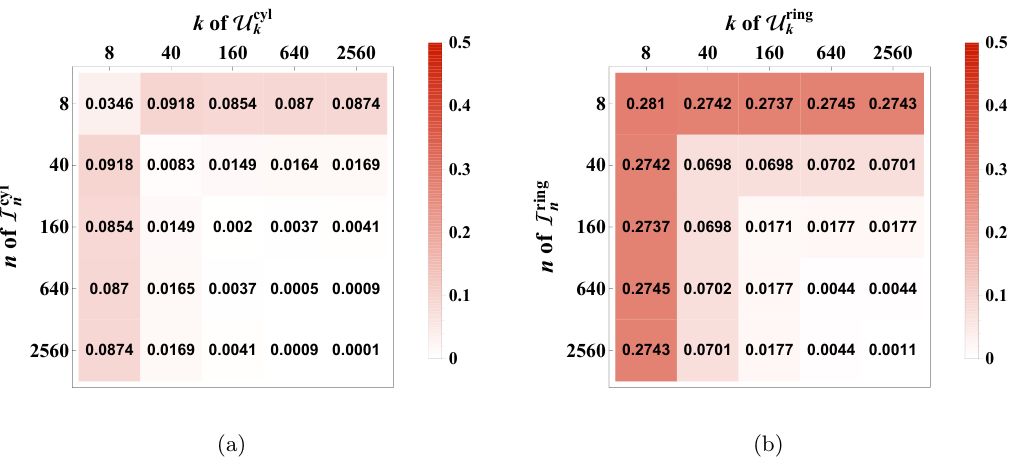
Figure 20 . The event isotropy for k -body quasi-isotropic samples, averaged over random orienta- tions. Shown are (a) I cyl computed on cylindrical events and (b) I ring n